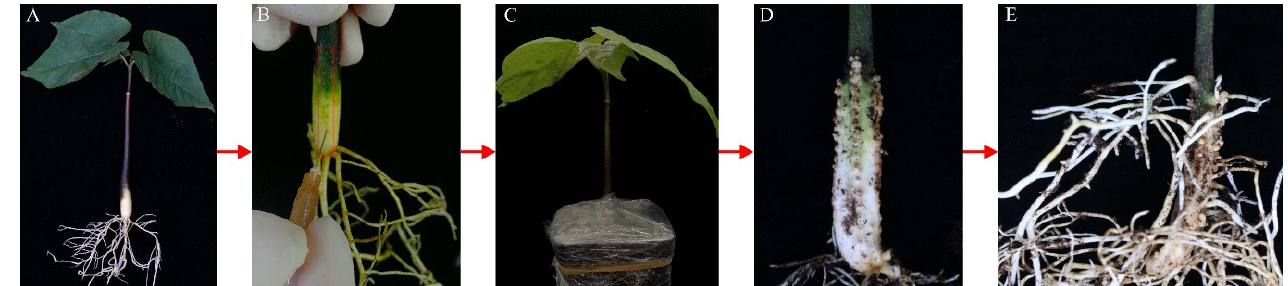
Figure 1. The flow chart of the modified K599-mediated hairy root induction method used for tung tree. ( A ) Photograph of a tung tree seedling 14 days after germination, before inoculation. ( B ) The stem segments as prepared for injection and the method of injection are shown. Inoculum of K599, which had a measured OD 600 approximately equal to 0.2, was injected along the four equally spaced lines in the 8 cm stem segment above the root. The four lines are distributed in four opposite directions, with equal spacing and an angle of 90° between the lines. ( C ) The surface of the mud of the pot was covered with a transparent plastic wrap after injection. ( D ) Calli that developed two weeks after injection along the injection lines are shown. ( E ) Stem segments four weeks after injection, showing the hairy roots that were produced along the injection lines.